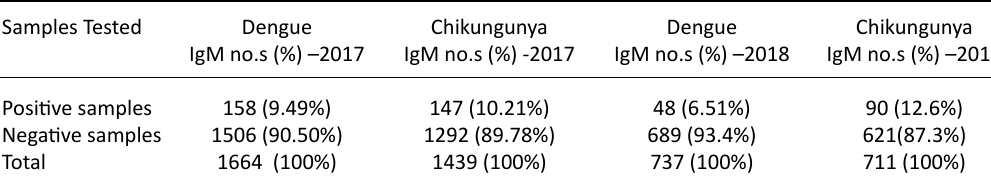
table 1. Seroprevalance of Dengue and Chikungunya infection Samples Tested